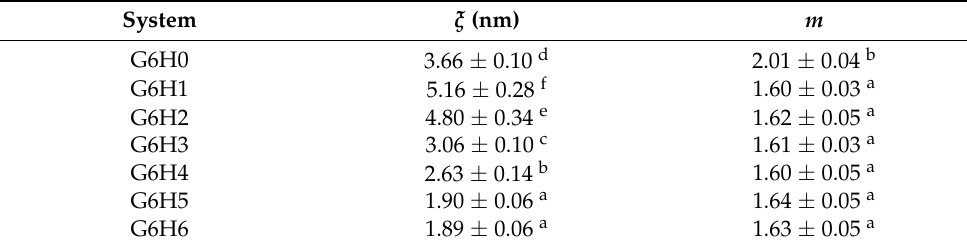
Figure 7. SAXS profiles of different GA/HPMC blended gels. The data are fitted based on the correlation length model. Table 2. Fitted SAXS parameters of GA and GA/HPMC blending